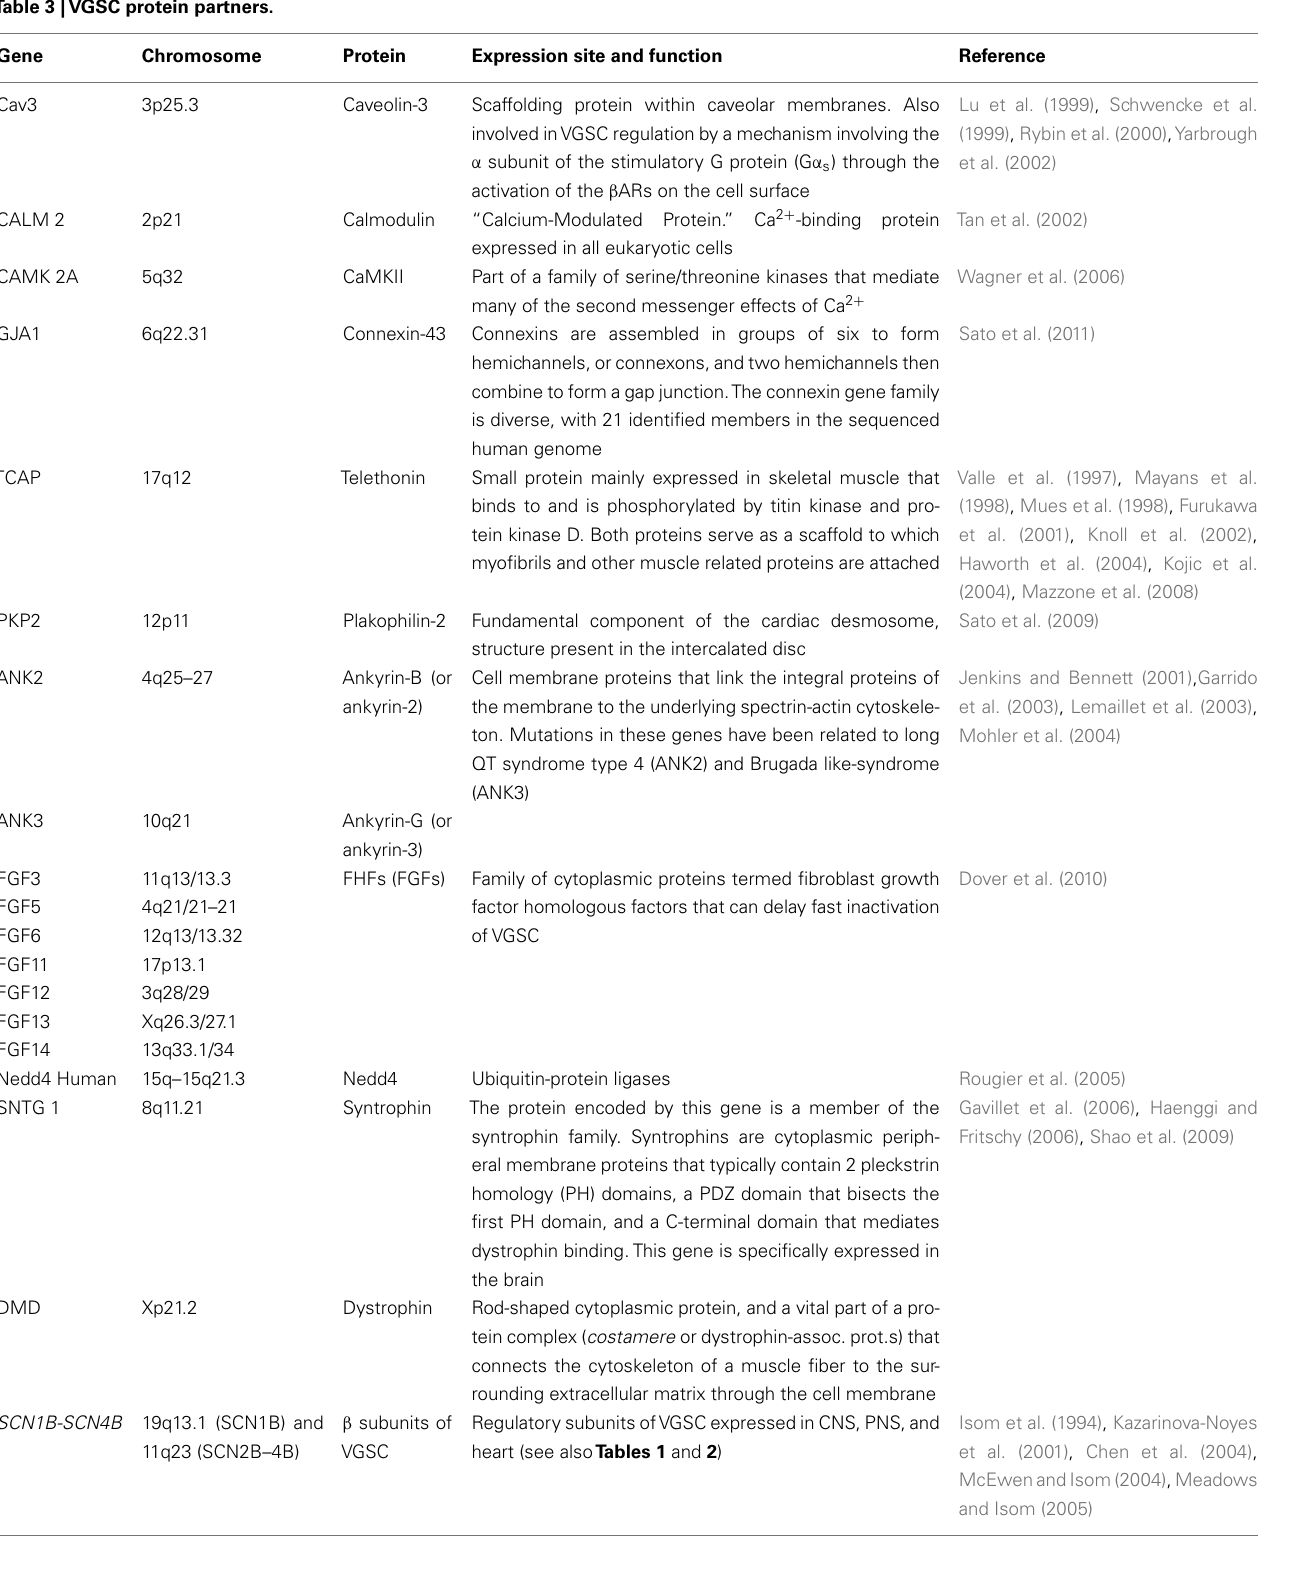
Table 3 |VGSC protein